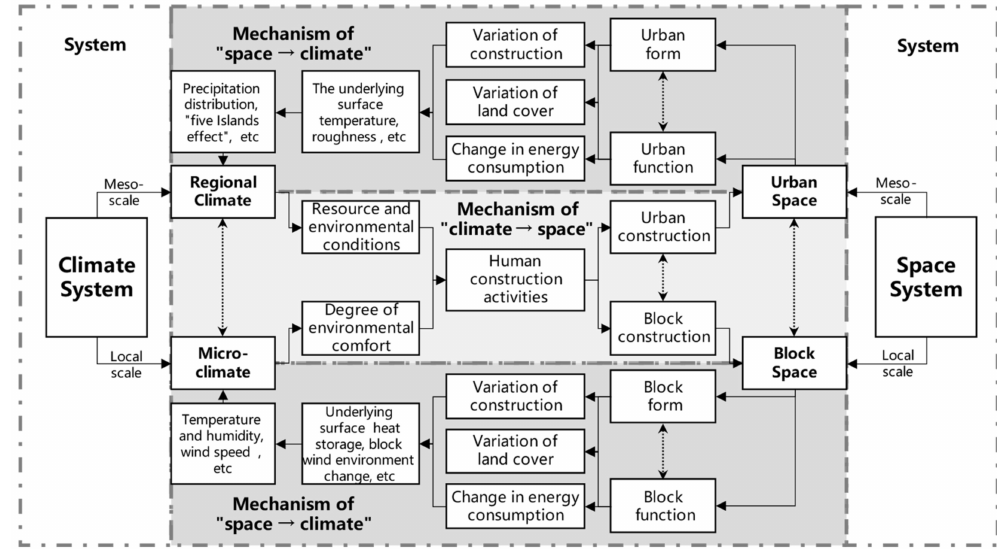
Figure 1. Coupled modelling regional climate and urban spatial